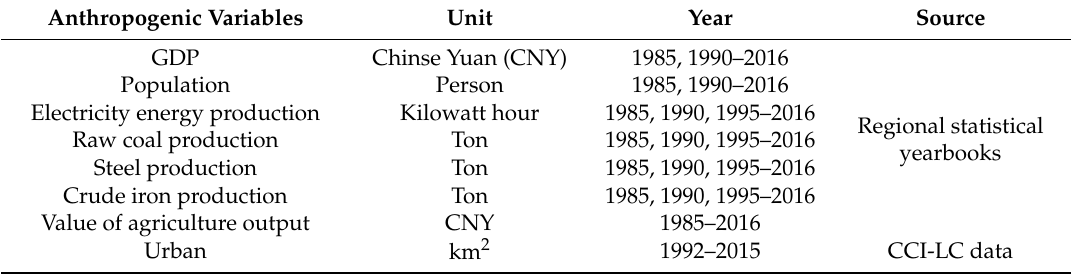
Table 1. Anthropogenic variables used in this study.